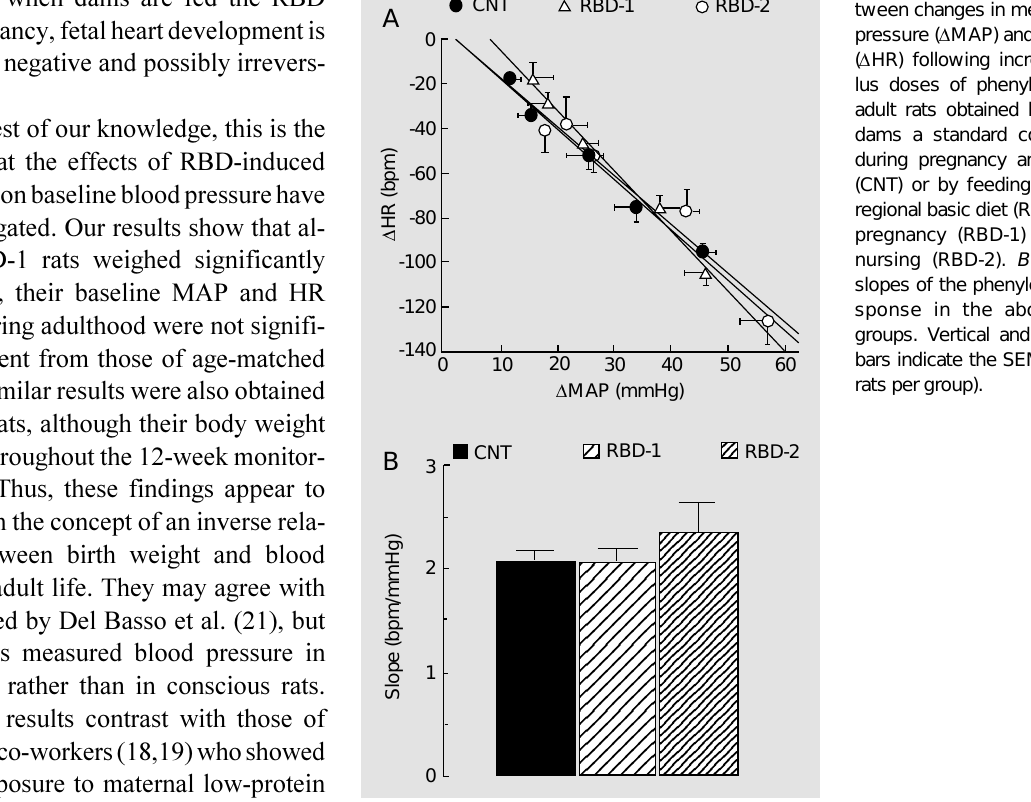
Figure 3 - A , Relationship be- tween changes in mean arterial pressure ( D MAP) and heart rate ( D HR) following increasing bo- lus doses of phenylephrine in adult rats obtained by feeding dams a standard control diet during pregnancy and nursing (CNT) or by feeding them the regional basic diet (RBD) during pregnancy (RBD-1) or during nursing (RBD-2). B , Average slopes of the phenylephrine re- sponse in the above three groups. Vertical and horizontal bars indicate the SEM (N = 8-9 rats per